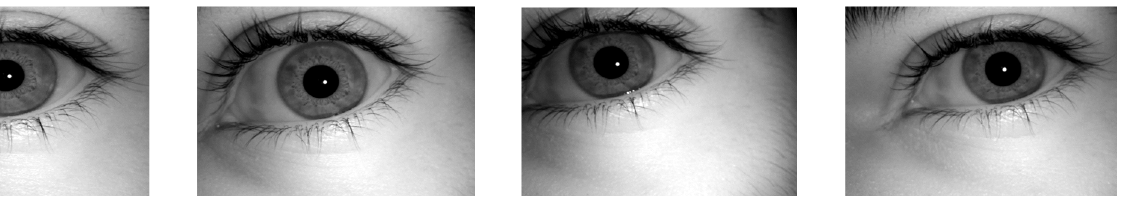
Figure 1. Four right eye images of one person.